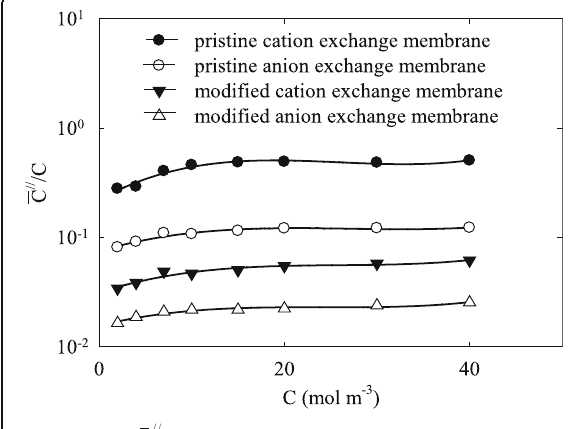
:== C as a function of concentration of outer